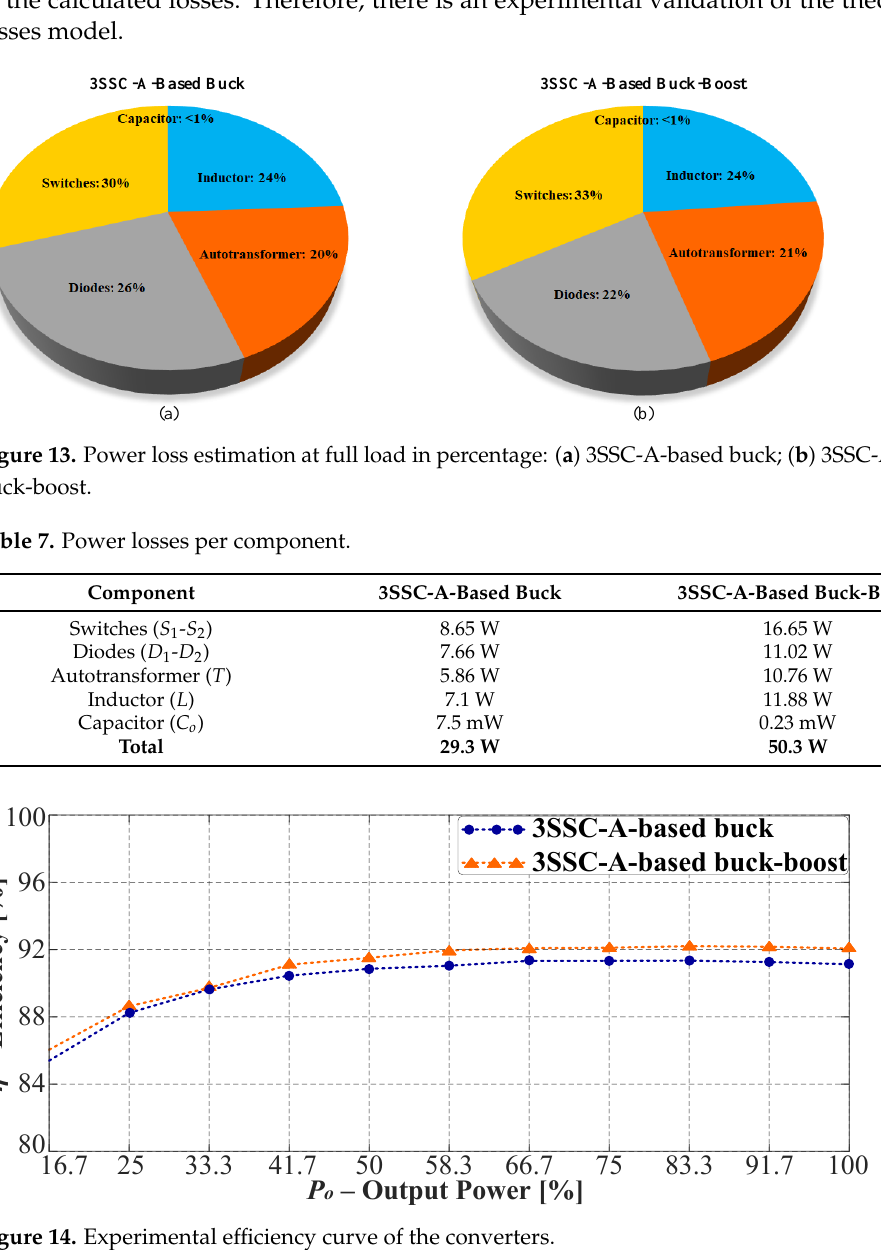
Figure 14. Experimental efficiency curve of the